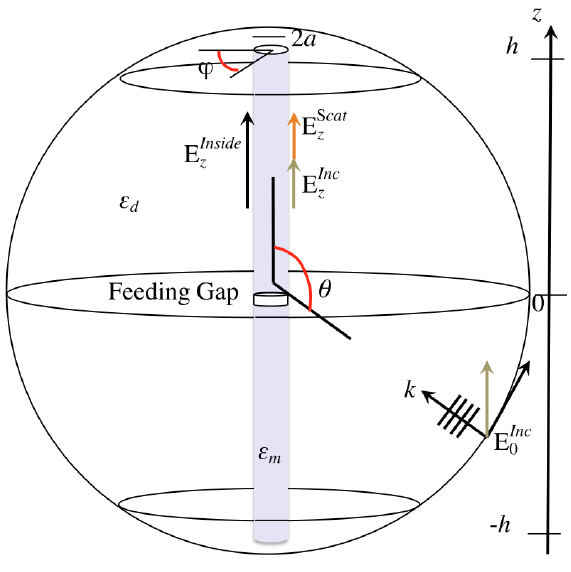
Figure 1: Plasmonic nano-dipole antenna considered in our